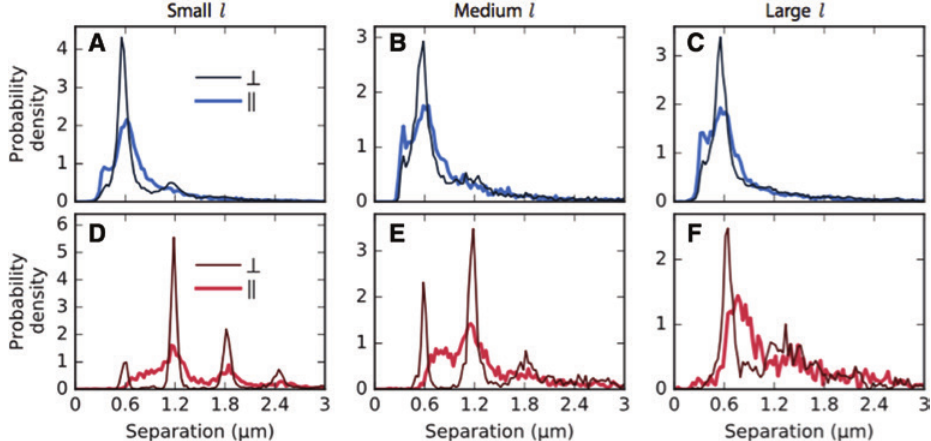
Figure 9: Conditional probability distributions of nearest neighbour nanoparticle separations grouped into categories of applied forces. (A), (D) small ( ℓ = 0 – 2), (B), (E) medium ( ℓ = 3), and (C), (F) large ( ℓ = 4 – 5) for experiments with particles over glass (blue, top row) and over a silver nanoplate (red, bottom row). Each panel shows distributions for particle pairs parallel (thick light-coloured curve) or perpendicular (thin dark-coloured curve) to the polarisation. Reproduced with permission from